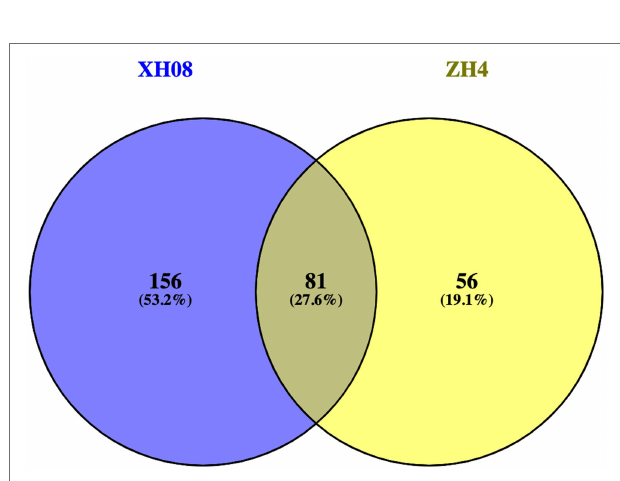
FIGURE 4 | The Venn diagram indicating a comparison of DAPs between XH08 and